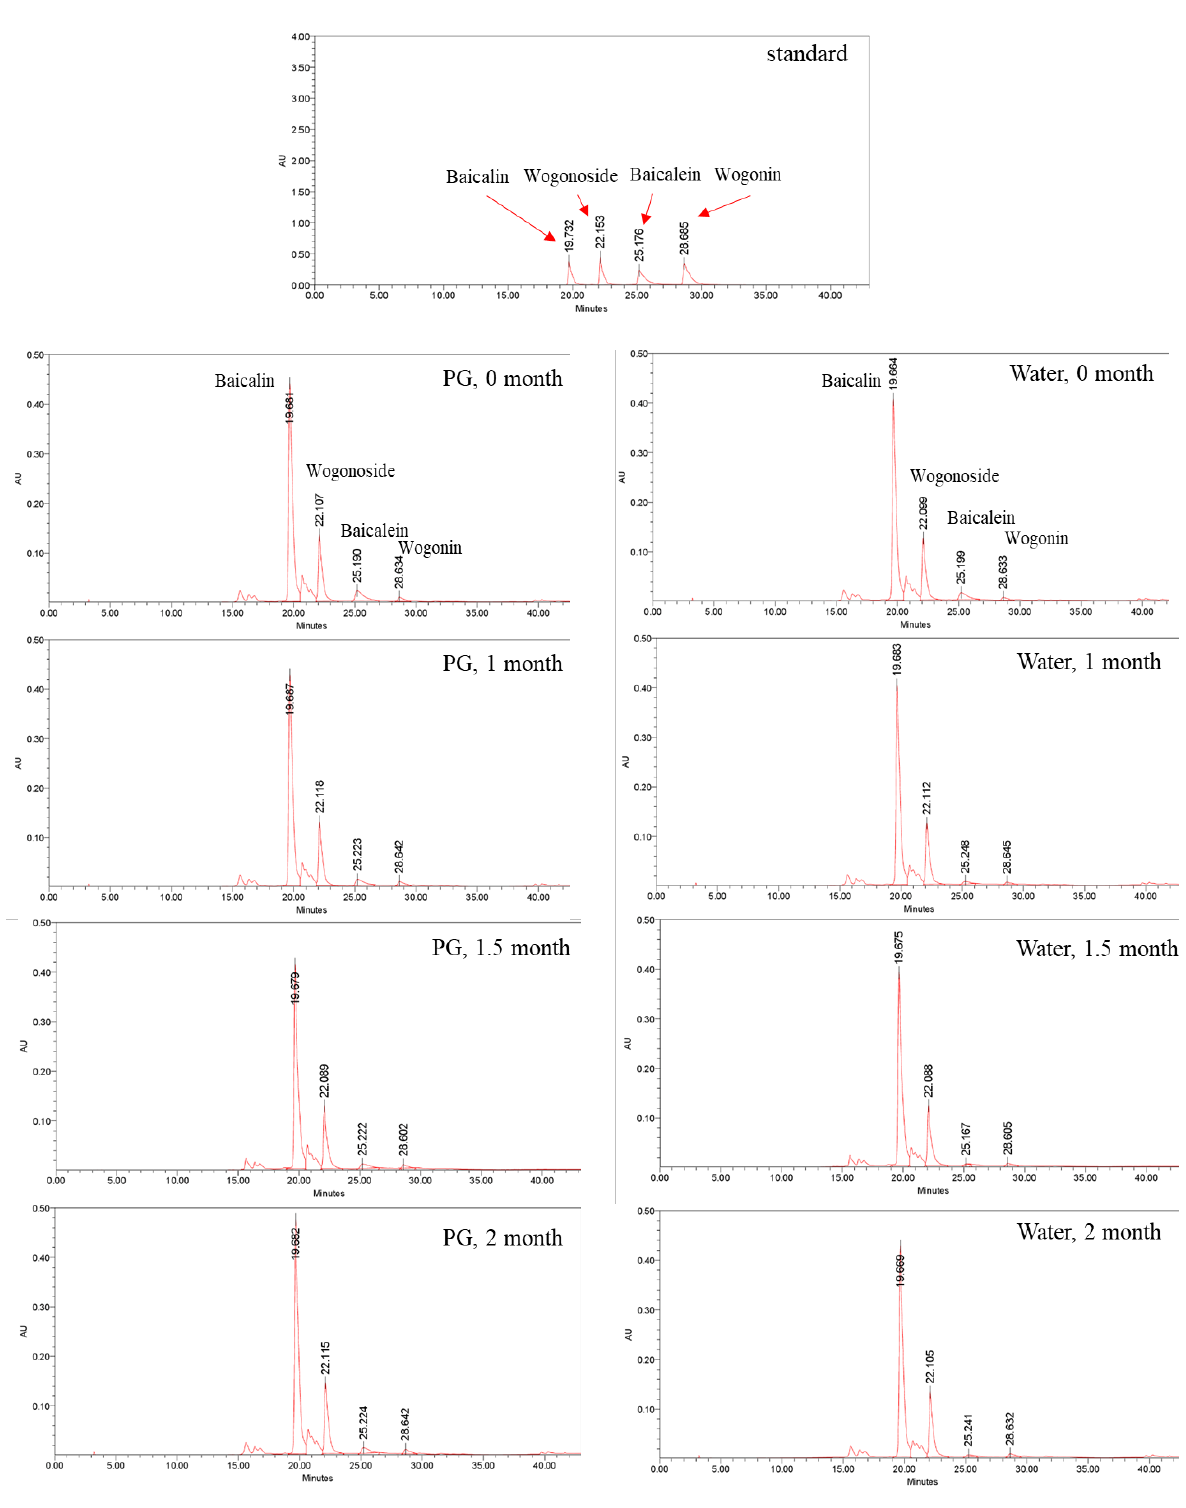
Figure 2. HPLC chromatograms of baicalin, wogonoside, baicalein and wogonin from the Scutellaria baicalensis extract (SBE) stored in 20% PG or water for different numbers of months.